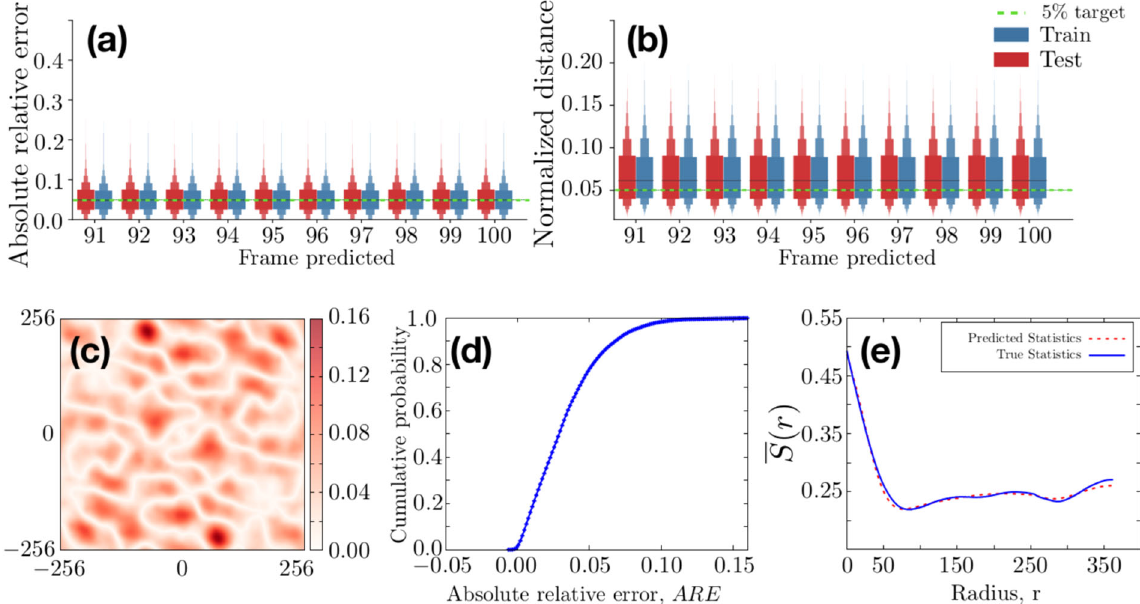
Fig. 4 Performance and predictability of LSTM-trained surrogate model. a Predicted absolute relative error, ARE ð k Þ t i ð Þ , from frames t 91 to t 100 . b Predicted normalized distance, D ð k Þ t i ð Þ , from frames t 91 to t 100 . In a , b the dashed green line indicates the 5% error value, while the black lines indicate the mean value of the absolute relative error and normalized distance, respectively, at various frames t i . c Point-wise error comparison of the predicted vs. true autocorrelation for a microstructure randomly selected in our test set. d Cumulative probability distribution of the ARE at frame t 100 for that microstructure. e Comparison of the predicted (dotted red line) vs. true (solid blue line) radial average